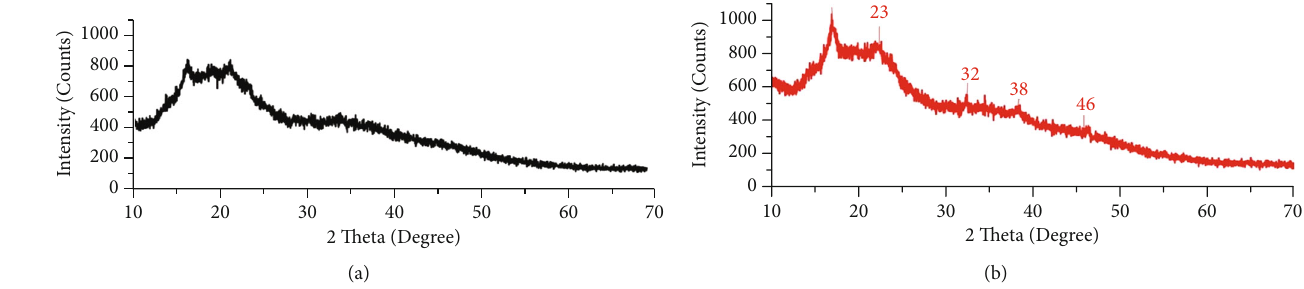
Figure 6: XRD spectra of the (a) PS-based fi lm and (b) active fi lm.